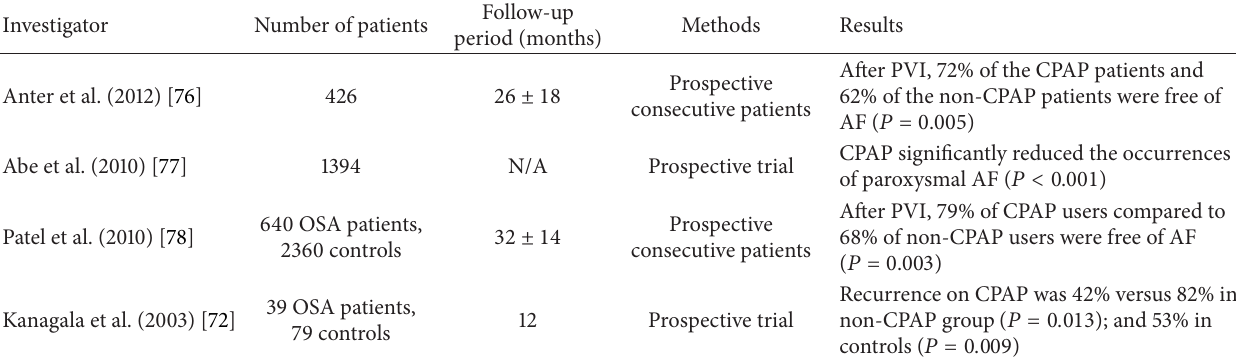
Table 3: Does CPAP improve AF outcomes?